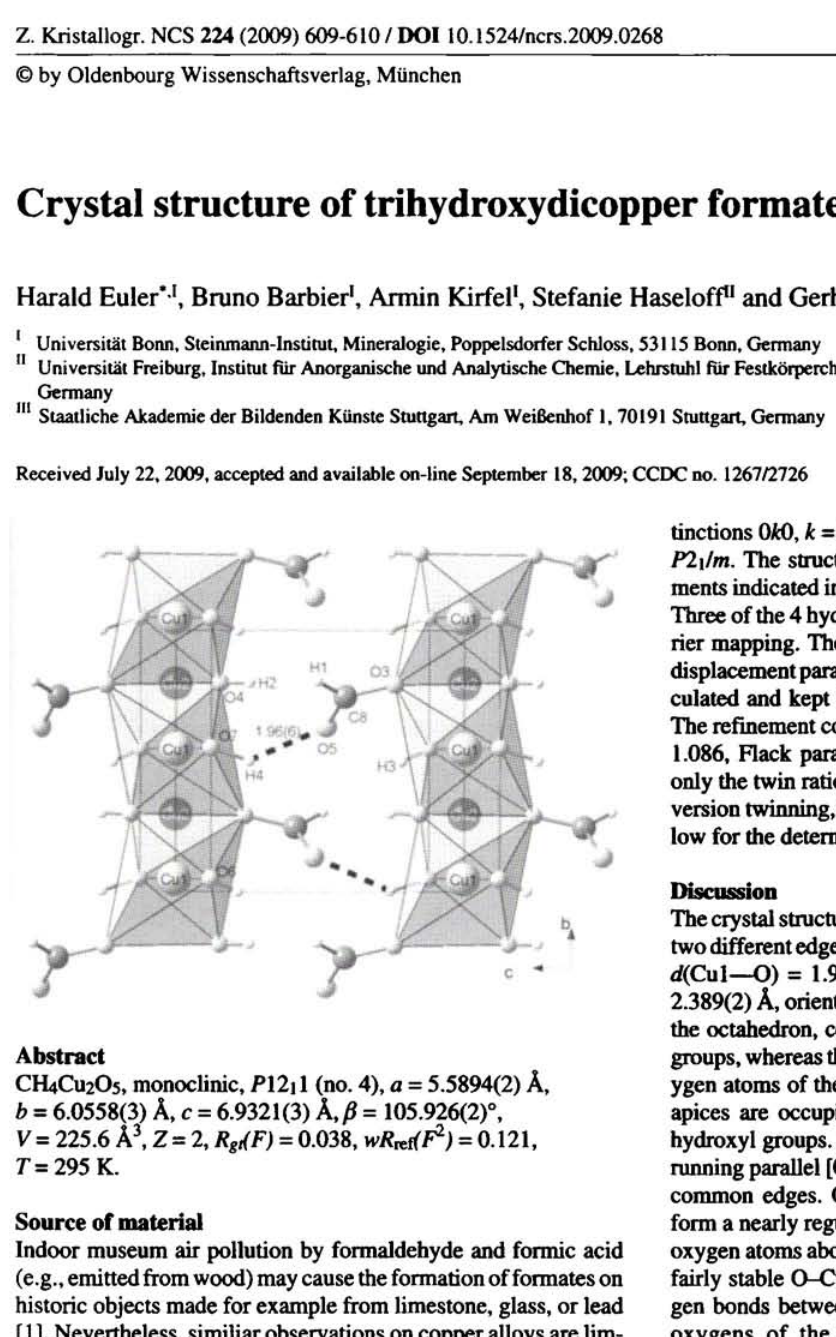
Table 1. Data collection and